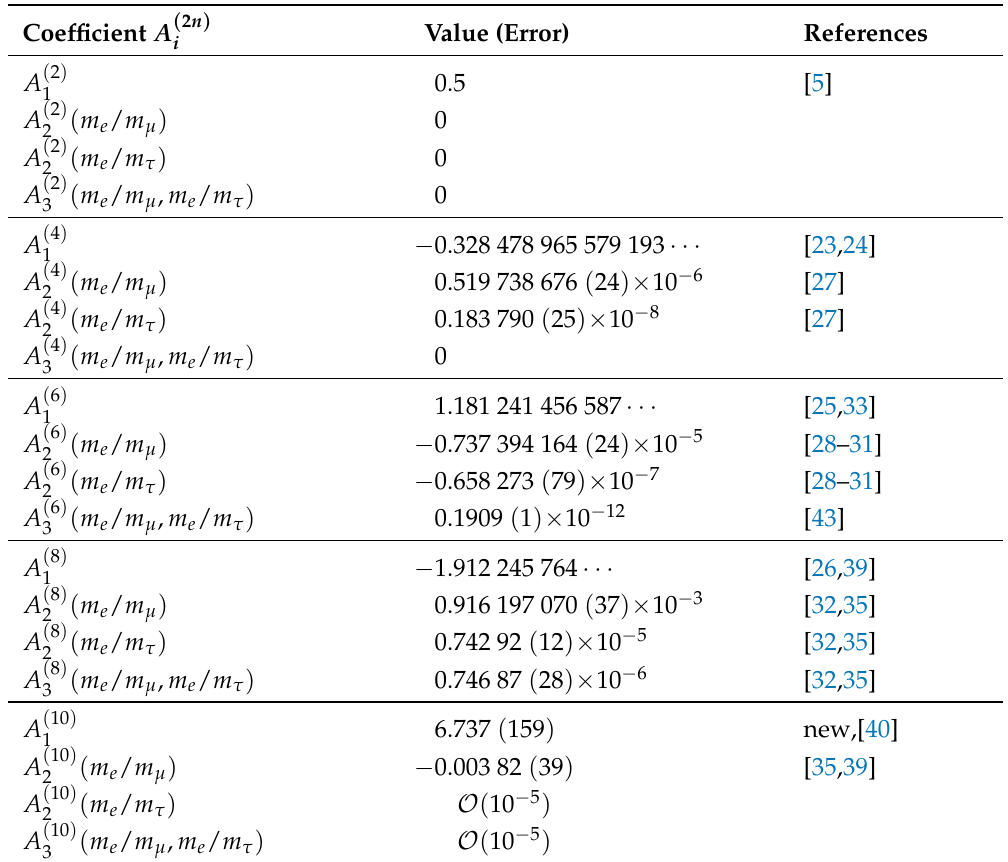
Table 1. QED contributions to the electron anomalous magnetic moment a e . The coefficients of ( α / π ) n , ( 2 n ) A , where n denotes the 2 n th-order of the perturbation theory of QED, are listed. No input parameter i ( 2 n ) is used to compute A , while the electron-to-muon mass ratio m e / m µ = 0.483 633 170 (11) × 10 − 2 [41] 1 and the electron-to-tau mass ratio m e / m τ = 0.287 585 ( 19 ) × 10 − 3 [42] are used for A The assigned uncertainties for the fourth-, sixth-, and eighth-order mass-dependent terms come from the lepton-mass ratios. The uncertainties of the tenth-order terms are due to numerical integration. The tau-lepton contributions to the tenth-order term have not yet been calculated, but they are suppressed by the factor ( m µ / m τ ) 2 compared with the muon